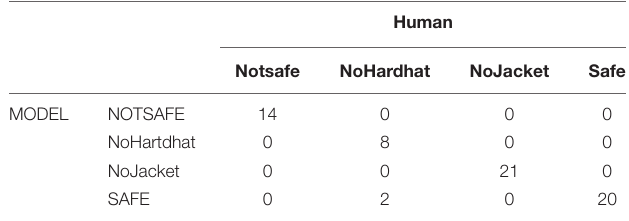
TABLE 6 | Confusion matrix for the novel